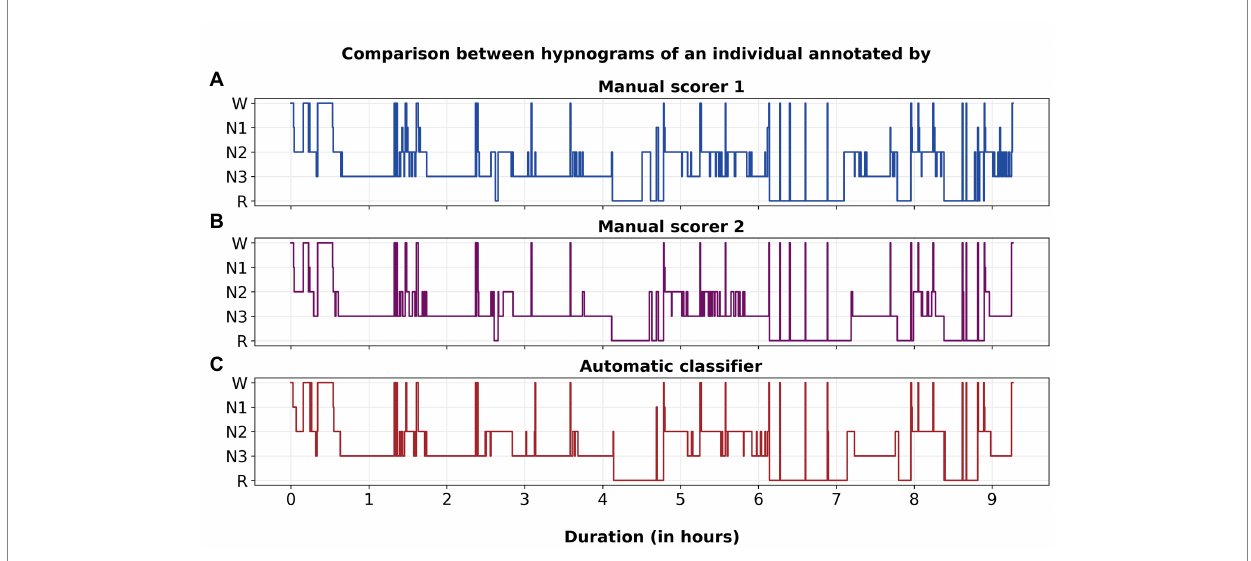
FIGURE 5 An example comparison between hypnograms of an individual annotated by (A) Manual scorer 1, (B) Manual scorer 2, and (C) Automatic classifier. The performance of the automated classifier in this individual was close to the population average (i.e., κ = 0.78 with manual scorer 1 and κ = 0.77 with scorer 2).